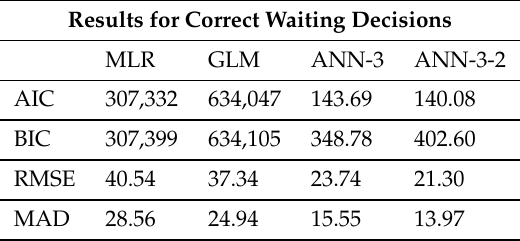
Table 3. Comparison of goodness of fit of MLR, GLM, ANN models with one hidden layer and with two hidden layers to the numbers of CWDs at the simulation end, measured by AIC, BIC, RMSE, MAD.